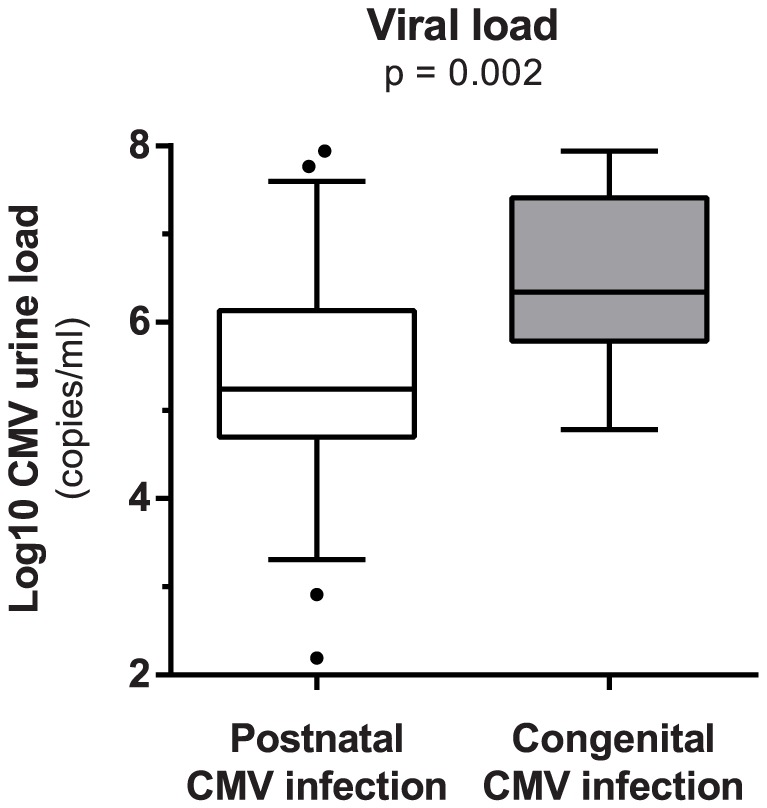
Log10 CMV urine load in postnatally and congenitally infected infants.Bar in boxplot represent median viral load after log10 transformation. Upper and lower limit of boxplot represent 75th and 25th percentile, respectively. Whiskers represent 5–95% coincidence interval. Dots represent outliers.